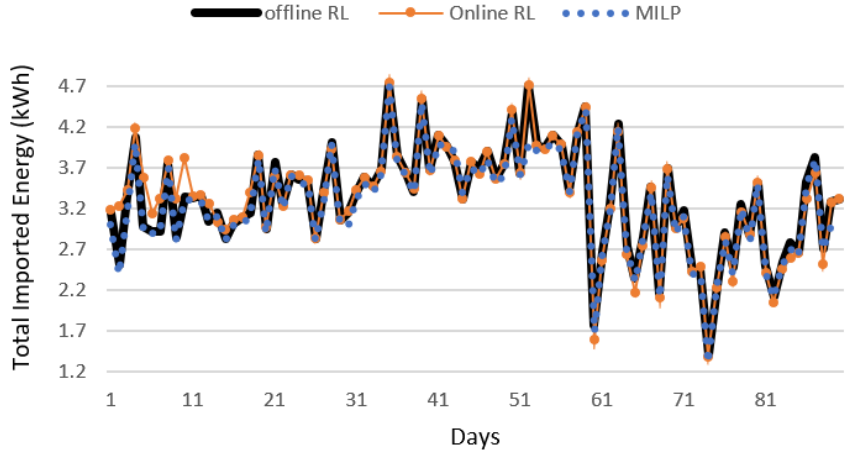
Figure 9. Performance of offline (ideal scenario) vs. online RL in terms of imported energy per day.